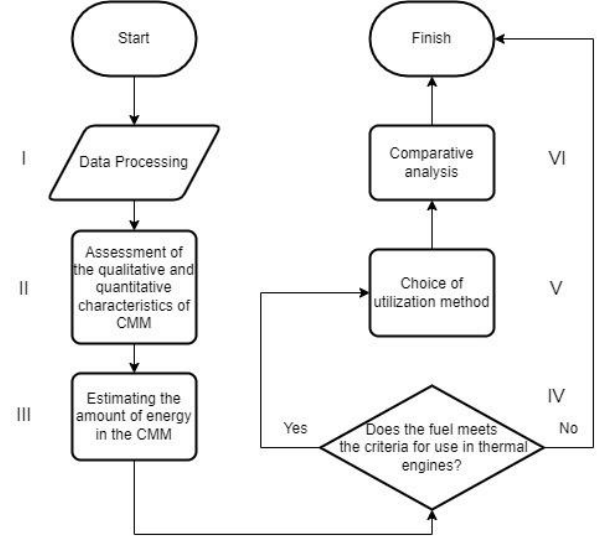
Figure 5. Algorithm for choosing a method of utilization of CMM. The algorithm in Figure 5 includes the following